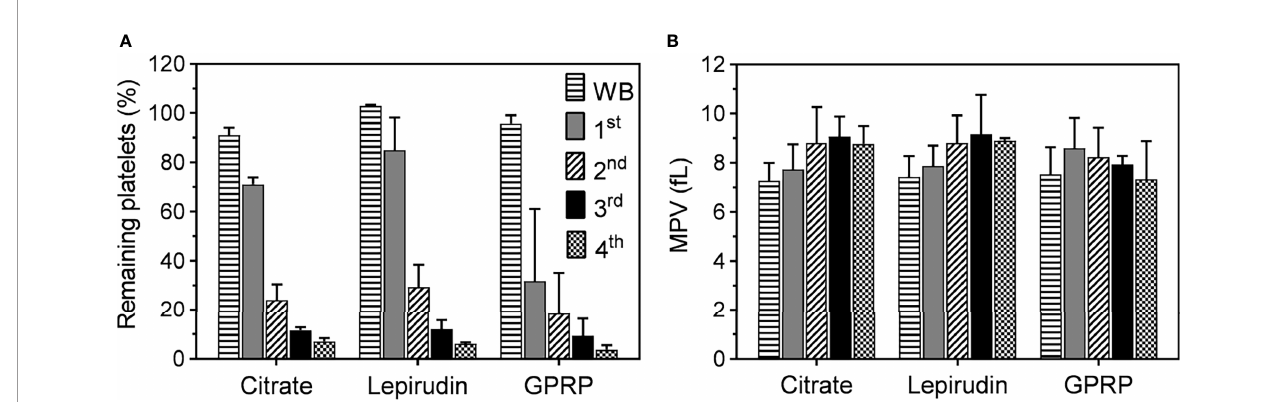
FIGURE 1 | Platelet counts and mean platelet volume (MPV) during the platelet separation process. (A) The number of platelets in whole blood immediately after collection (WB) and after the fi rst (1 st ), second (2 nd ), third (3 rd ), and fourth (4 th ) centrifugation. Blood was collected in tubes containing either lepirudin or GPRP, supplemented with 0.7% (w/v) citrate, (labelled in the graphs as “ Lepirudin ” and “ GPRP ” ) or 3.2% (w/v) citrate only (labelled as “ Citrate ” ), with blood to anticoagulant ratio 9:1. Data are presented as the normalized mean percentage of platelet number ± standard deviation (SD) for each donor (n = 9). (B) Mean platelet volume (MPV), as an indicator of platelet integrity, remained at <10 fl throughout the whole puri fi cation process. Data are presented as mean of MPV ± standard deviation (SD). Blood from each donor (n = 9) was analysed in